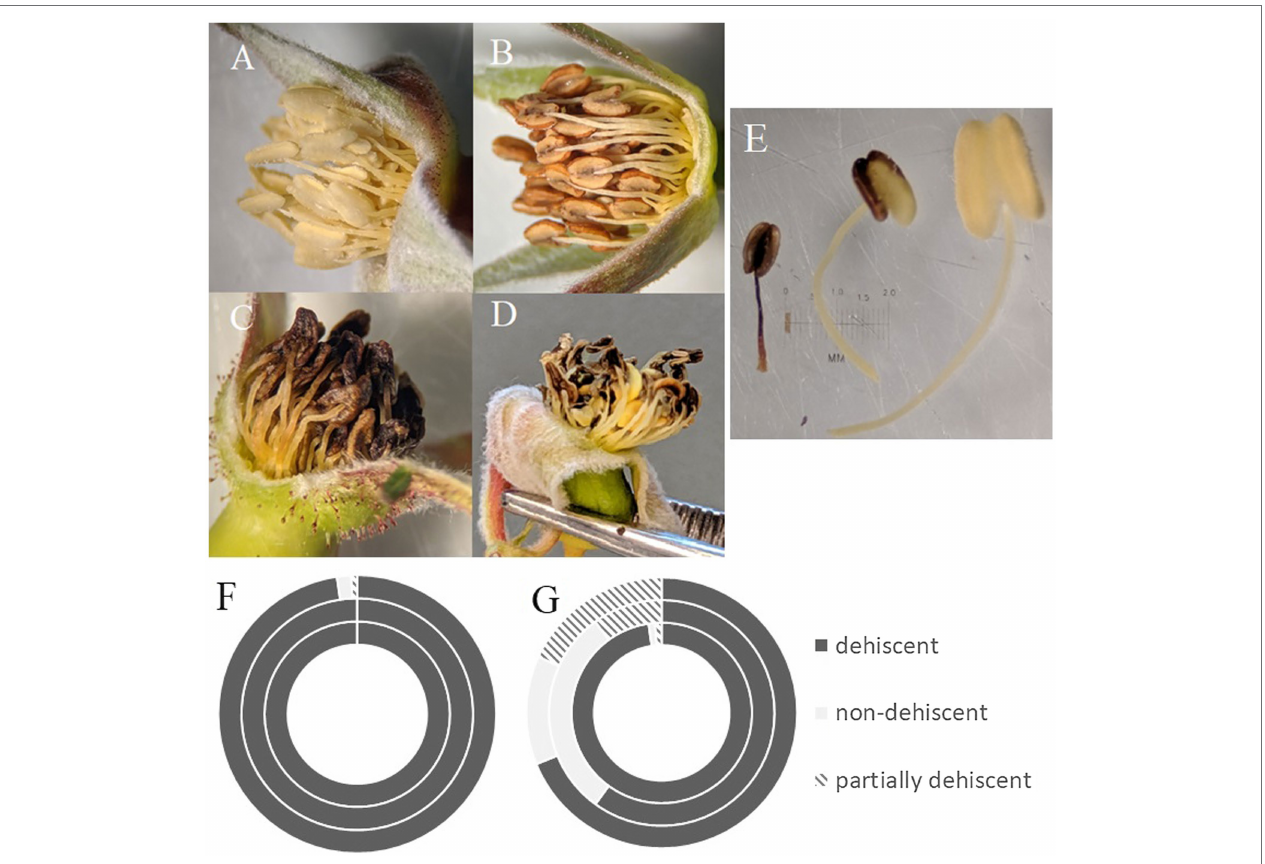
FIGURE 3 | Health of R. acicularis floral stamen samples from three sites one year after treatment with glyphosate-based herbicide and three control sites. (A) Stamen from a representative control individual; (B) stamen found in both buds and flowers at the Kaykay forest cutblock; (C) stamen found at the Hoodoo forest cutblock; (D) stamen found at the Bobtail forest cutblock; (E) example of the range of variability found in stamen on treated sites; (F,G) the number of individuals with either dehiscent, non-dehiscent, or partially dehiscent anthers found at control sites (F) and treated sites (G) where the outer ring is the Bobtail site, the middle ring is the Hoodoo site, and the inner ring is the Kaykay